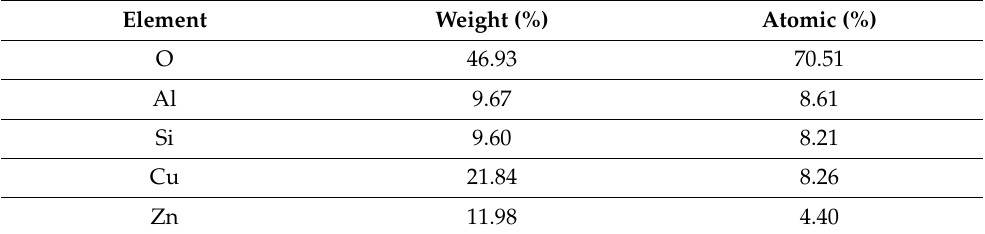
Table 1. Element quantification with EDX for the Cu/ZnO/zeolite material.